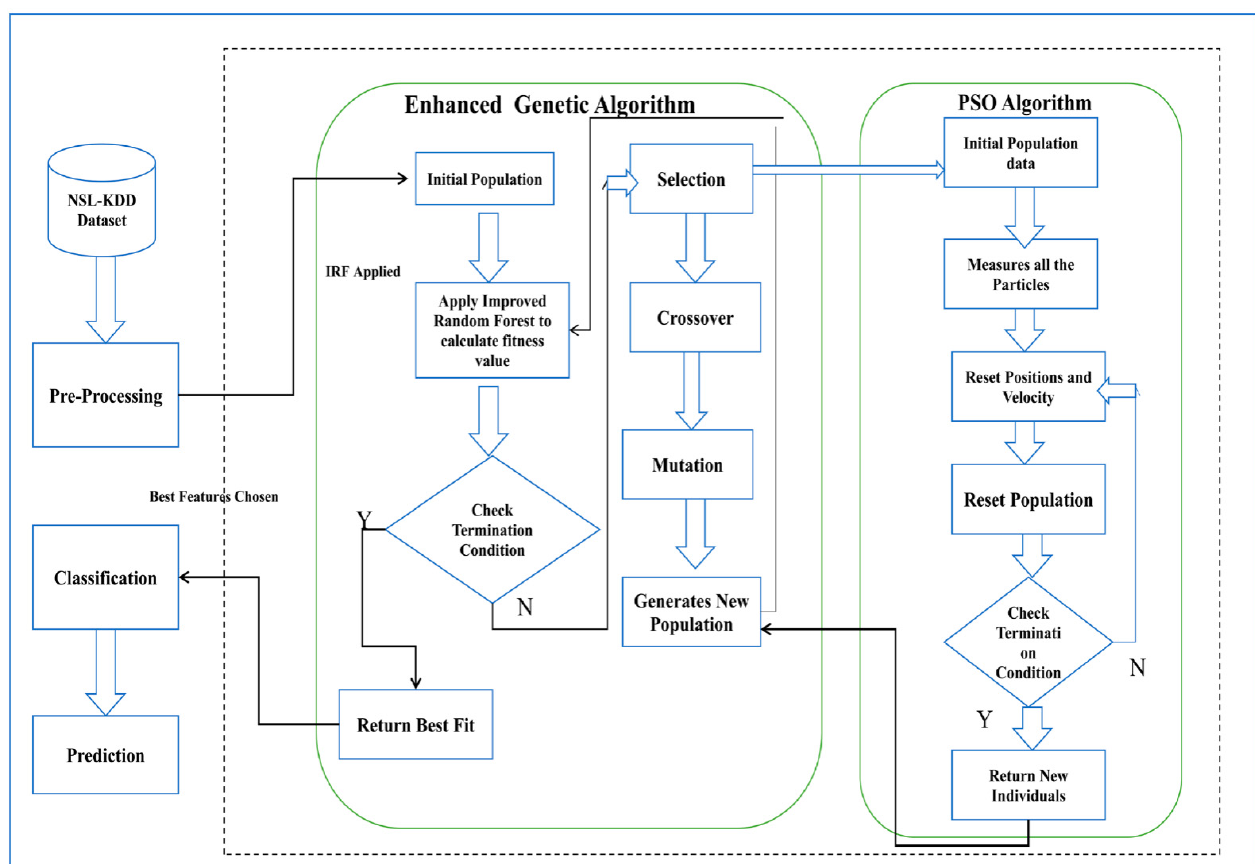
Figure 2. The working of the proposed hybrid IDS model